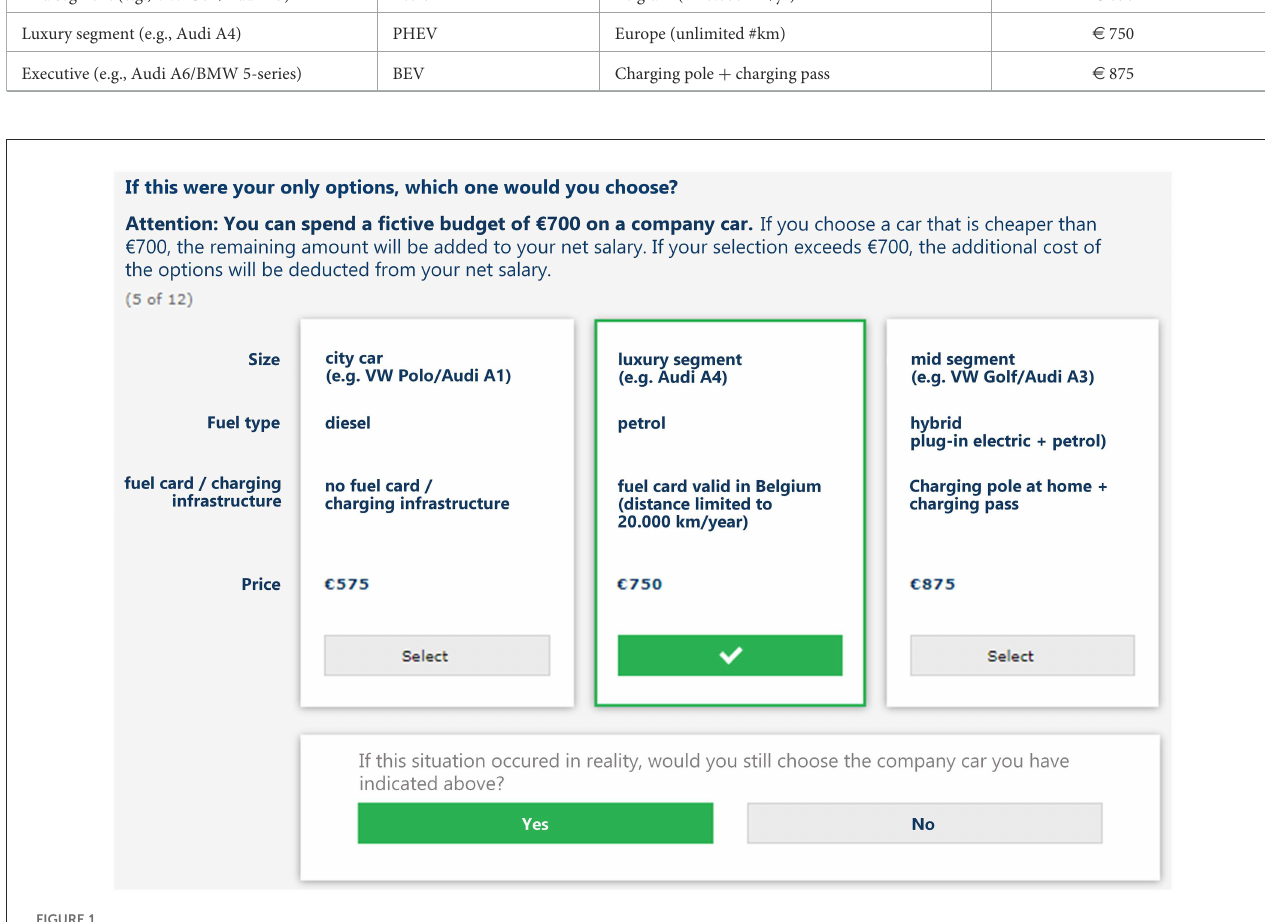
FIGURE1 Example of a choice task (translated from